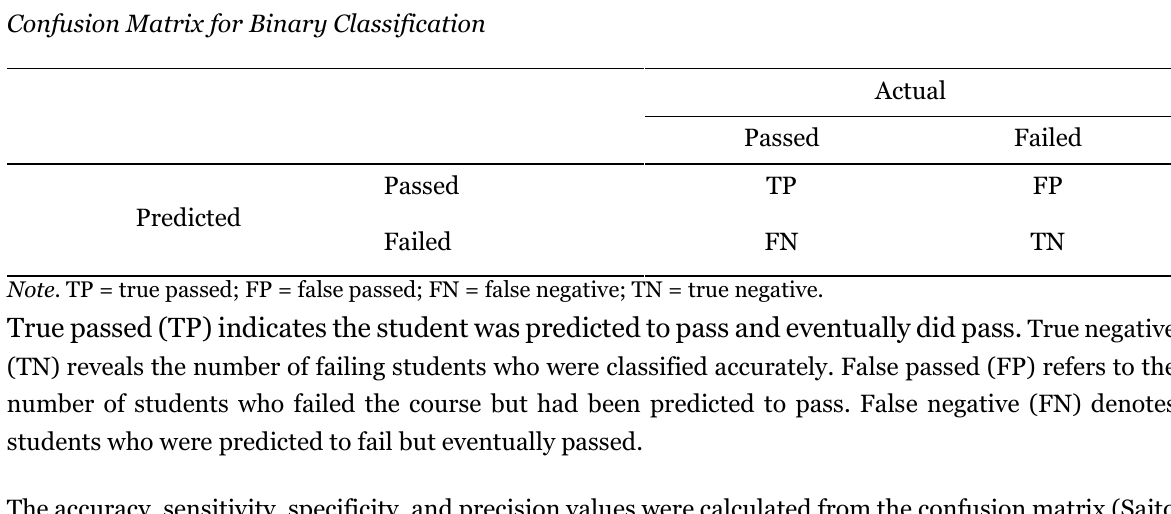
Table 3 Confusion Matrix for Binary Classification Predicted